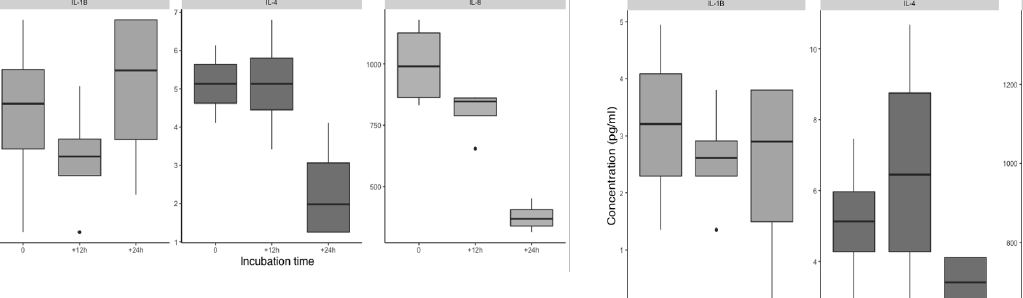
Figure 2. Incubation for 12 h - clarithromycin impact on pro- inflamma- tory mediators’ secretion. Figure shows the impact of clarithromycin, respectively, on IL-1β, IL-4 and IL-8 release by A459 cells. Before (incuba- tion time 0), after co-incubation (incubation time +12h), and 24 h after wash-out (incubation time +24h), cell culture supernatants were ana- lysed for the presence of the indicated cytokines by Luminex®. Values are expressed as mean ± SEM from 4 independent experiments.